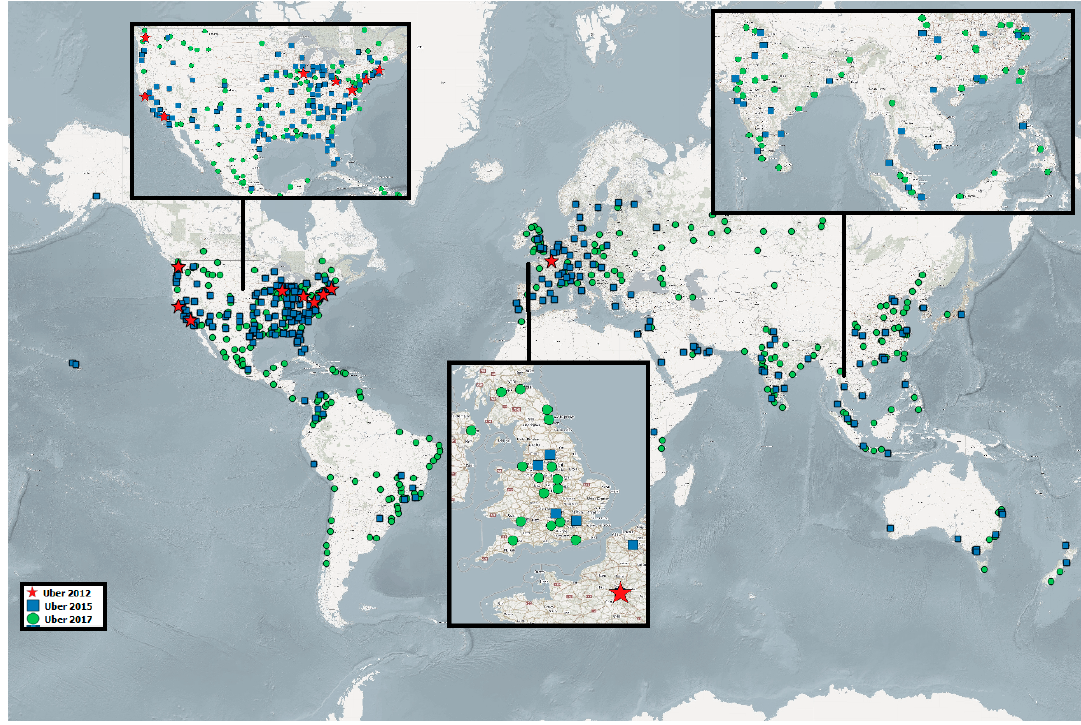
Figure 15. Global Uber supported cities 2012/2017 (World Mercator Projection).